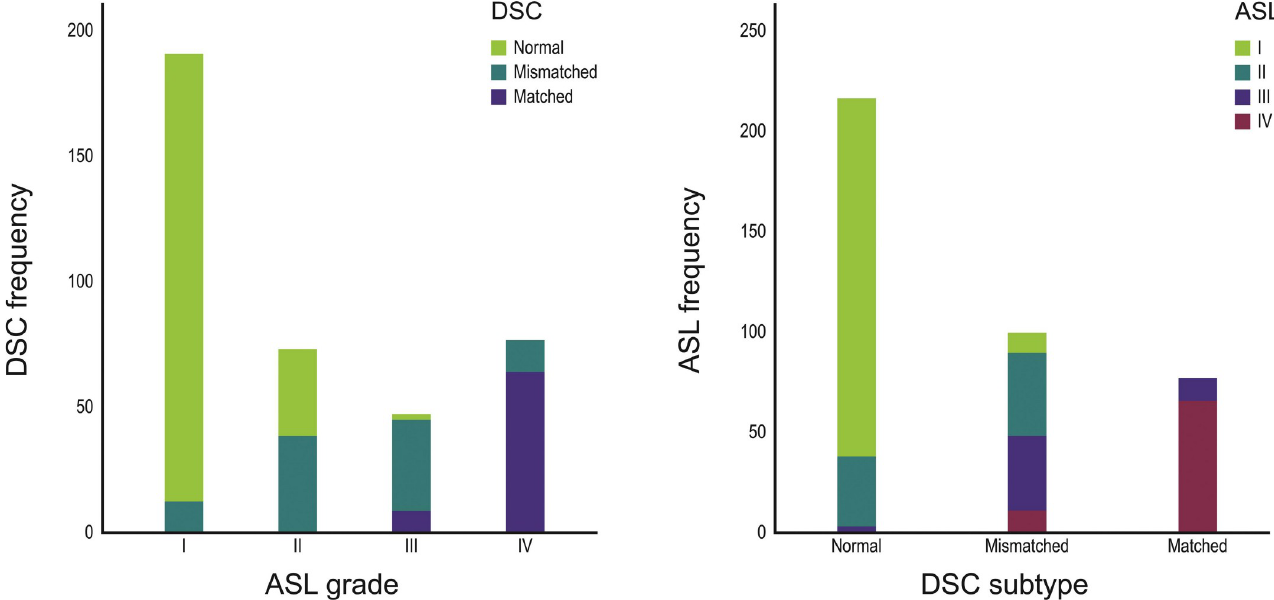
Fig 5. Distribution of the 384 areas showing perfusion abnormalities, visualized by arterial spin labeling (ASL) imaging and dynamic susceptibility (DSC) perfusion imaging, in the 32 patients with ischemic stroke (r = 0.82, p- = 0.01 by Spearman’s rank test). ASL-I refers to no PPD or HVS, II refers to no PPD with the presence of HVS, III refers to the presence of both HVS and PPD, and IV refers to the presence of PPD without HVS.